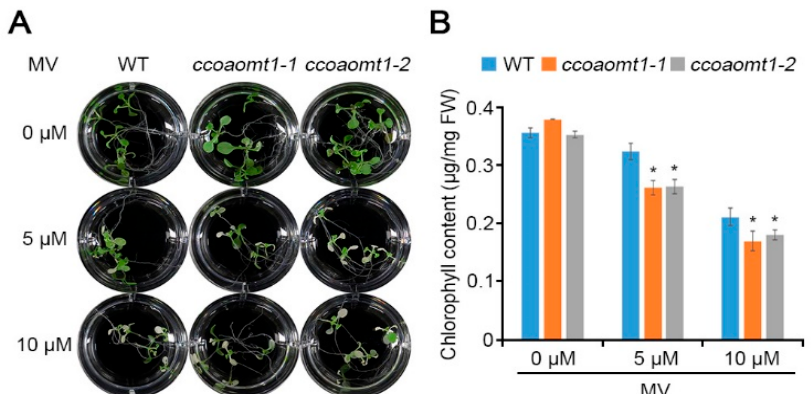
Figure 3. Hypersensitive phenotype of ccoaomt1 mutants under MV stress conditions. ( A ) Morpho- logical phenotype of WT and ccoaomt1 mutants ( ccoaomt1-1 and ccoaomt1-2 ). Ten-day-old seedlings were grown on MS medium in the presence of indicated concentrations of MV for two days; 0 µM, 5 µM, and 10 µM MV. ( B ) Chlorophyll contents. The quantitative values indicated means ± SD with five seedlings from three independent experiments. Asterisks represent significant differences from the WT (*, p < 0.05; Student’s t -test). We found that CCoAOMT1 is involved in plant responses to drought and MV